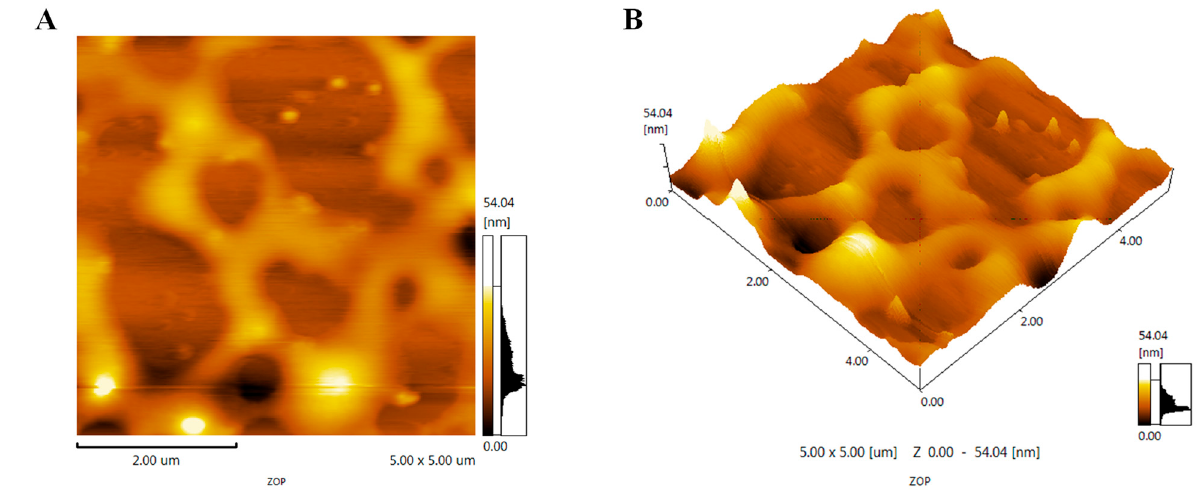
Figure 2. Plan view ( A ) and stereoscopic view ( B ) of AFM.